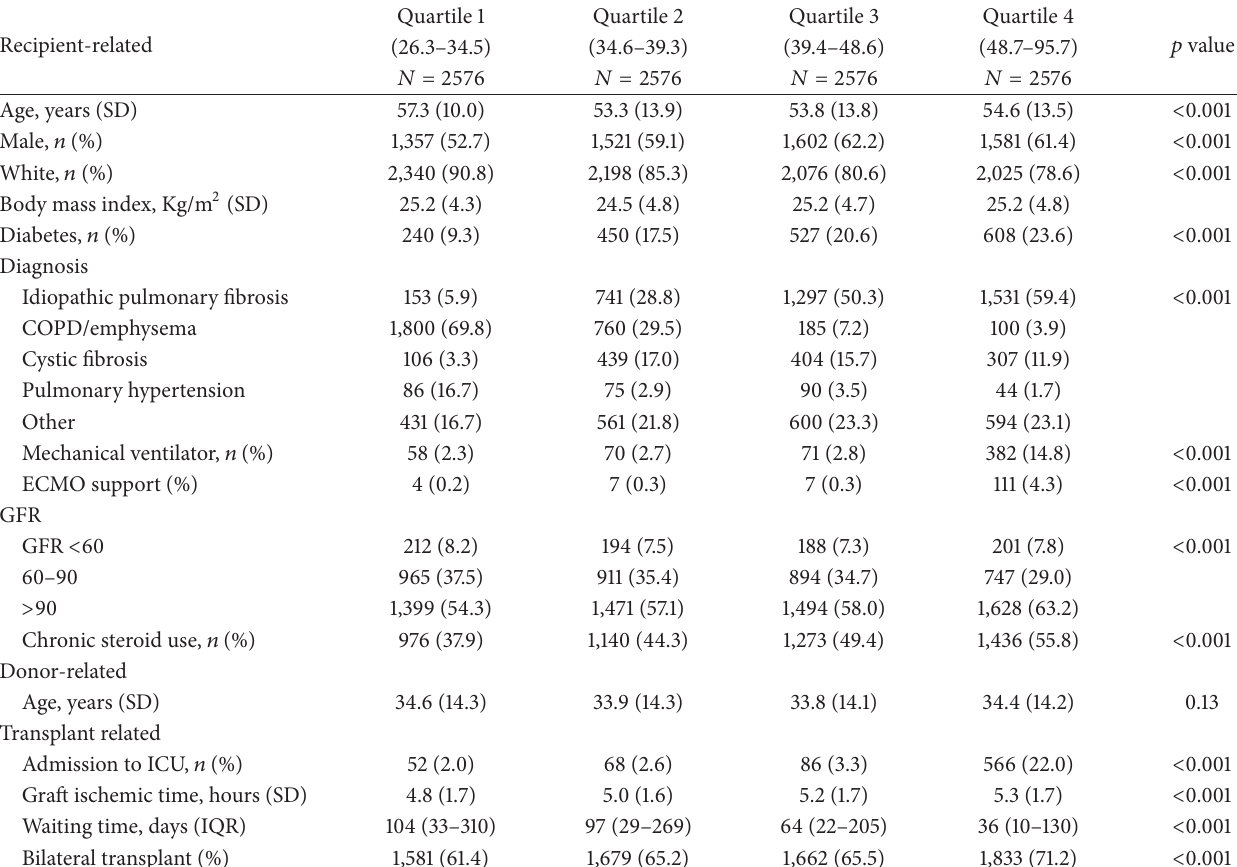
Table 1: Characteristics of patients at baseline, stratified by quartiles of LAS.